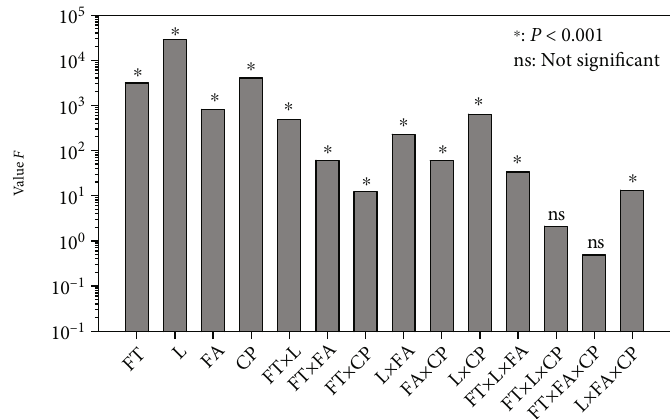
Figure 16: Signi fi cance tests of peak deviatoric stress considering interactions.